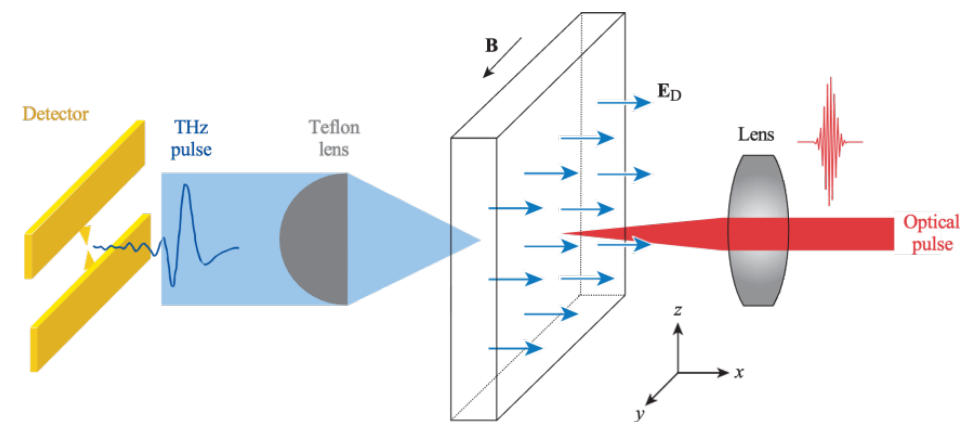
Figure 1. Schematics of the basic experimental geometry. The surface of the sample is parallel to the yz -plane. The built-in depletion electric field E D is along the x -axis and perpendicular to the sample surface. A lens is used to focus a laser beam at the surface of the sample, and a Teflon lens placed after the sample collimates the emitted THz radiation towards a PC THz detector aligned in such a way that it can only sense the z -component of the THz transient. An external magnetic, field applied along the y -axis, was used in the B -field enhancement experiments.